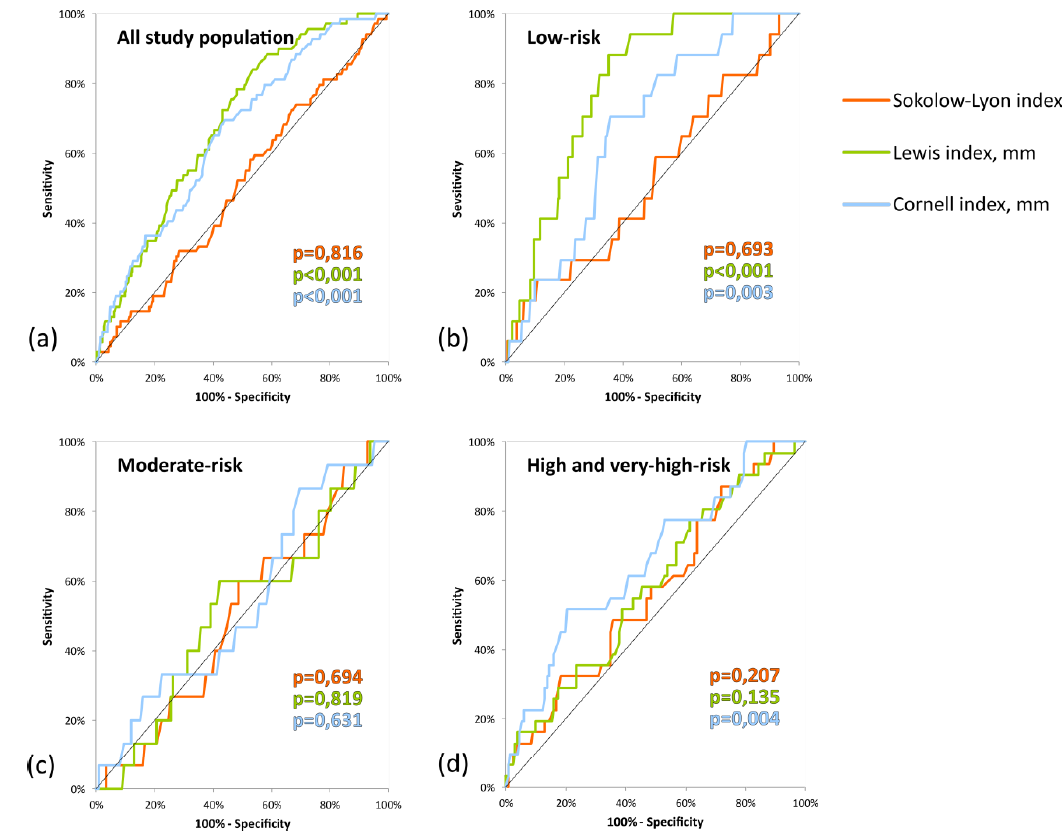
Figure 1. Receiver operating characteristic curves of the Sokolow–Lyon index, Lewis index, and Cornell index for recognized left ventricular hypertrophy in echocardiography (ECHO) using left ventricular mass indexed to body surface area (LVMI BSA ): (a) all study population; (b) low cardiovascular risk; (c) moderate cardiovascular risk; (d) high and very-high cardiovascular risk.